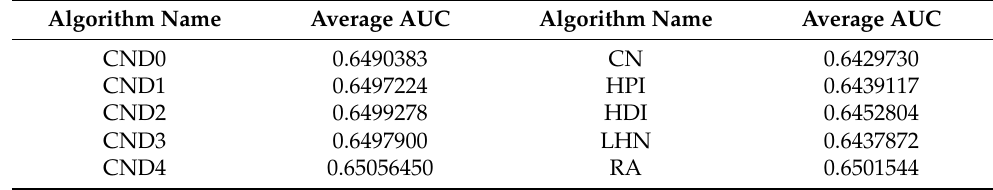
Figure 6. Performance comparison of newly defined SDIs and original SLPA.